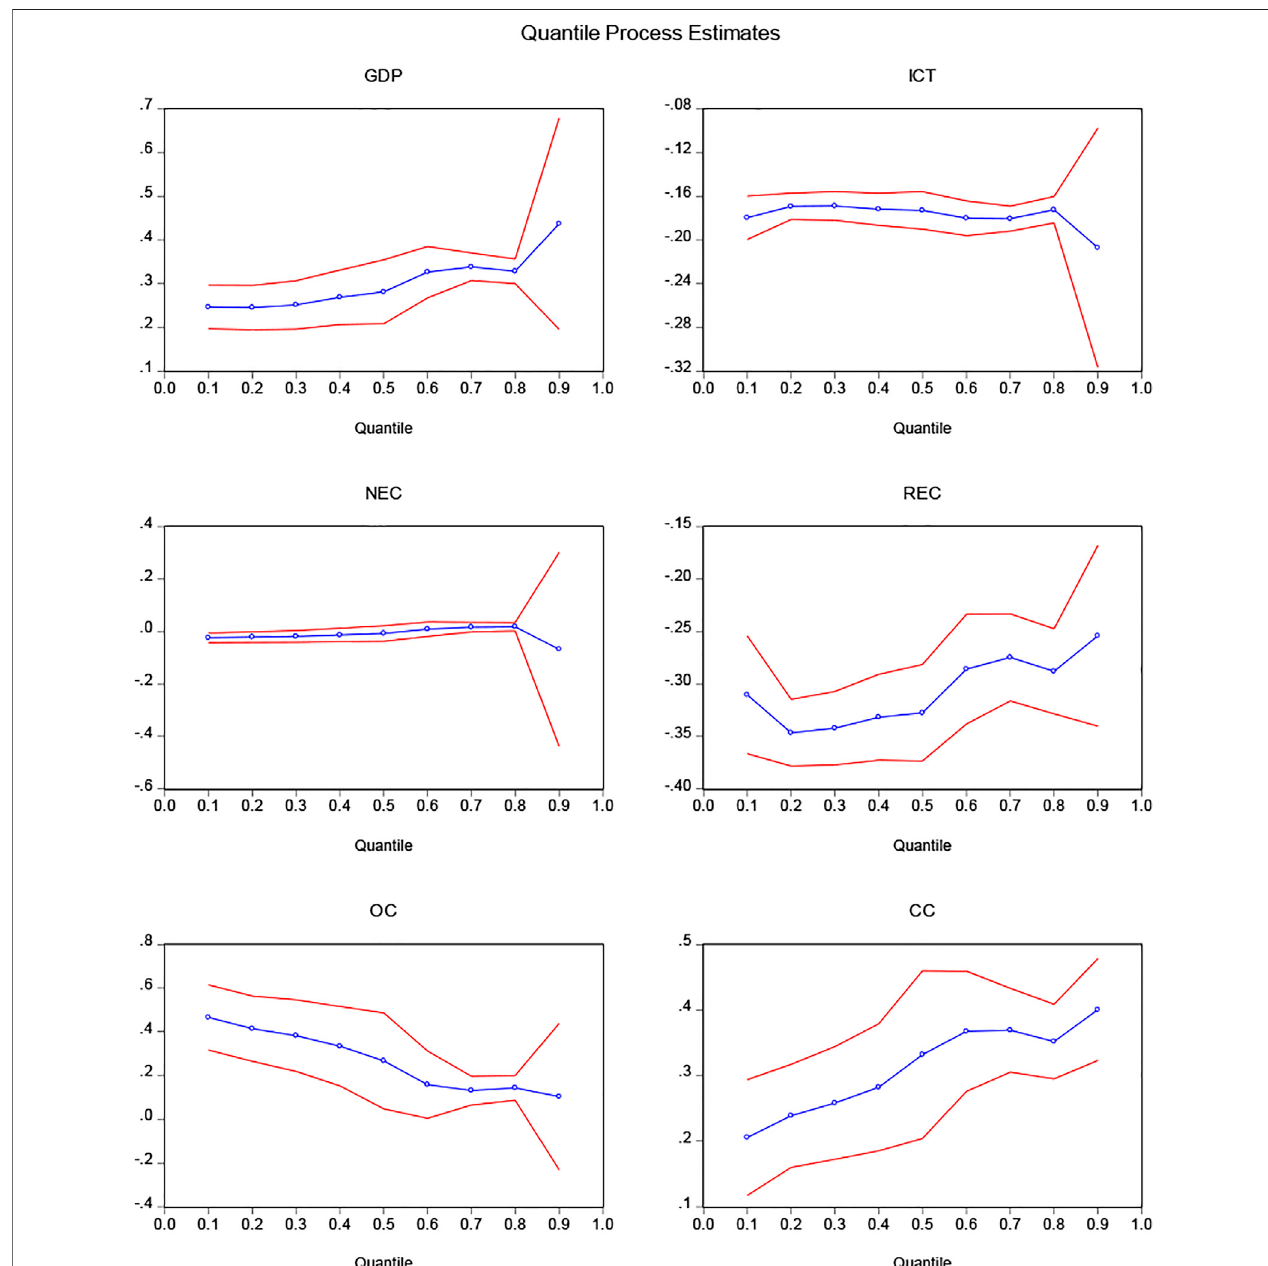
FIGURE 2 | Summary of the Quantile Process